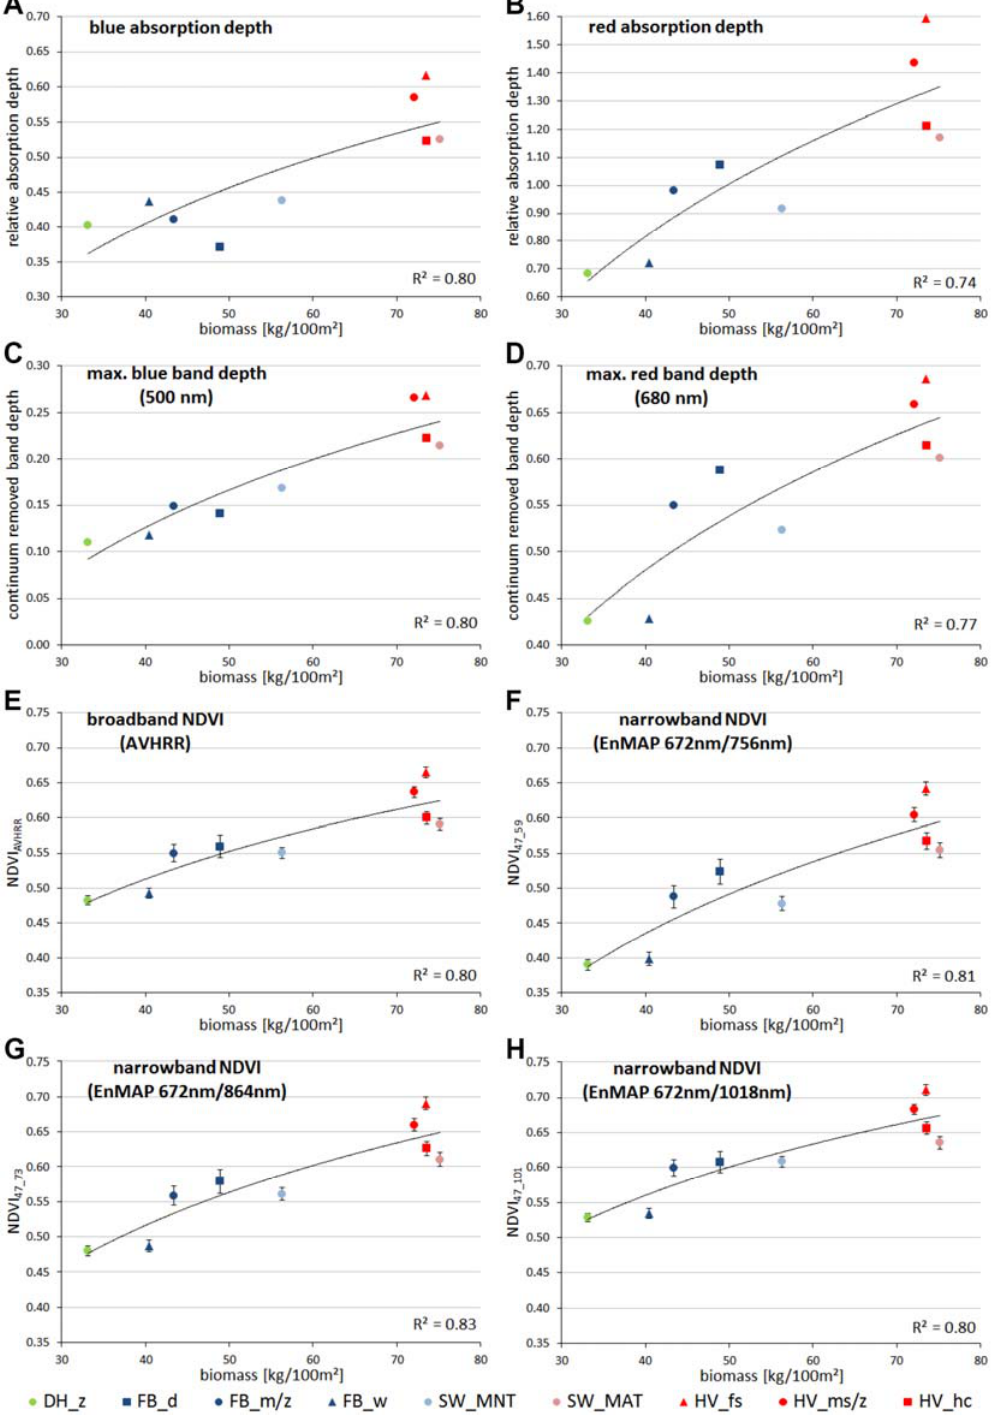
Figure 8. Spectral metrics of the study sites as a function of biomass. ( A ) Relative blue absorption depth vs. biomass; ( B ) Relative red absorption depth vs. biomass; ( C ) Continuum removed maximum blue band depth vs. biomass; ( D ) Continuum removed maximum red band depth vs. biomass. Correlation between ( E ) broadband NDVI with biomass compared with three ( F – H ) narrowband NDVIs with